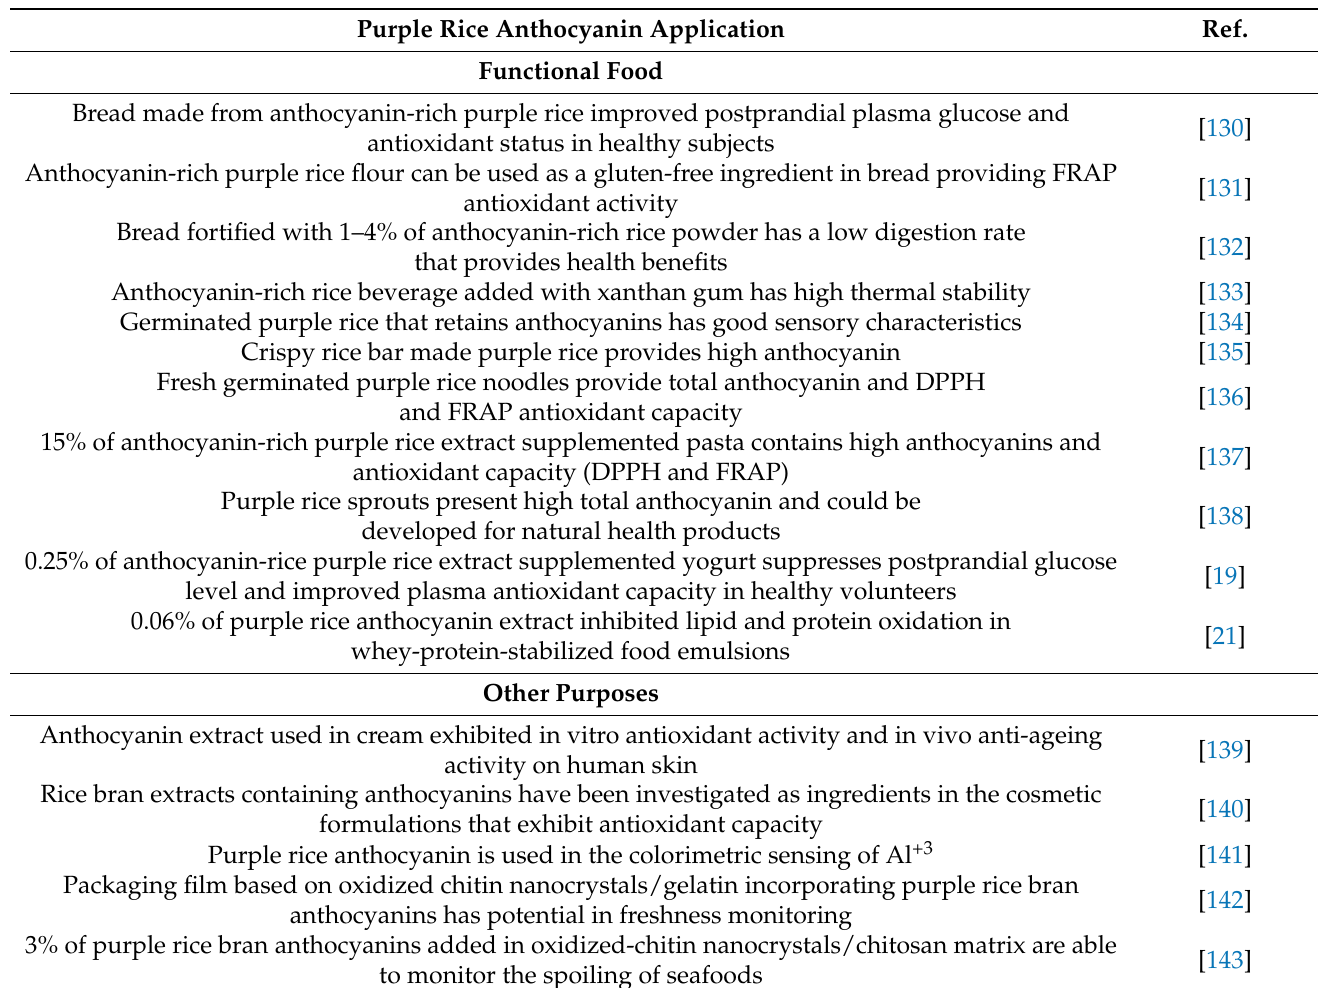
Table 4. Different applications of purple rice anthocyanins in functional food and other